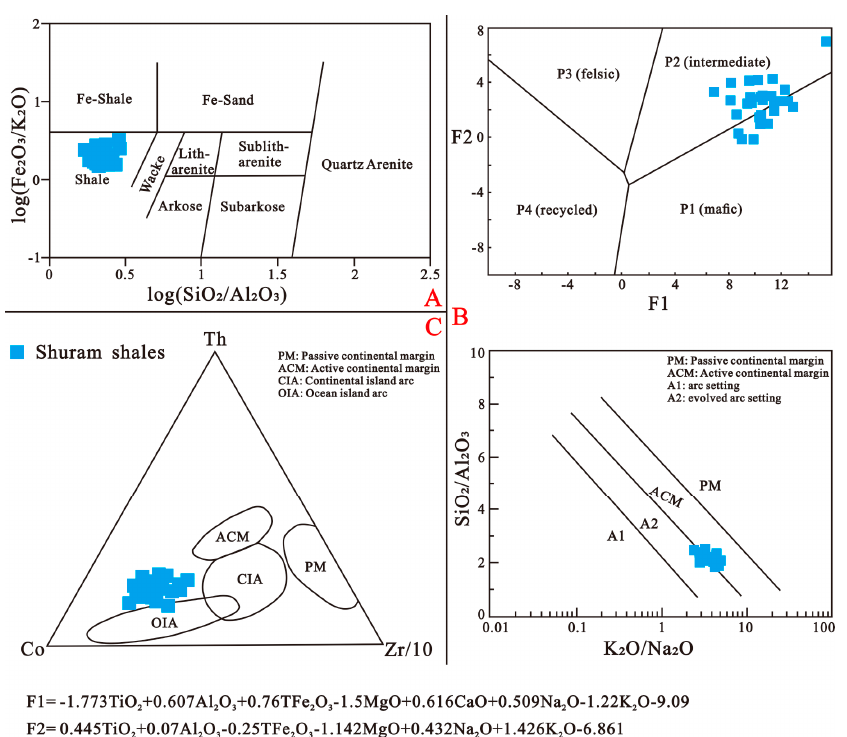
Figure 3. ( A ) Geochemical classification of the sedimentary samples based on the Herron diagram [52]; ( B , C ) Tectonic setting discrimination diagrams for Shuram Formation shales: major elements [51,53] and trace elements [50]. P1 (mafic): first-cycle basaltic and lesser andesitic detritus; P2 (intermediate): dominantly andesitic detritus; P3 (felsic): acid plutonic and volcanic detritus; P4 (recycled): mature polycyclic quartzose detritus. A1: arc setting, basaltic and andesitic detritus; A2: evolved arc setting, felsitic-plutonic detritus.